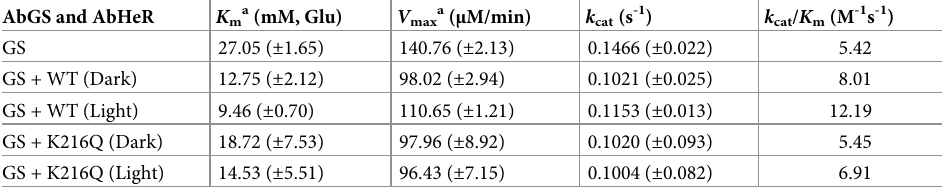
Table 2. Steady-state enzyme kinetic parameters for AbGS without and with AbHeR in the absence and presence of light in a Mn 2+ -supported biosynthetic reaction. AbGS and AbHeR K ma (mM,